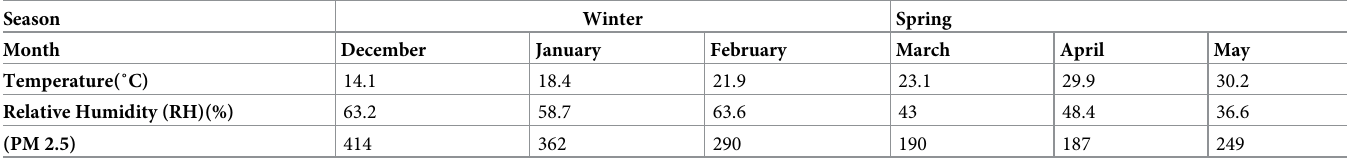
Table 4. Description of the meteorological parameters of the sampling areas (Particulate Matter PM 2.5 Data source: Ambient Air quality monitoring system (DPCC) Ashok Vihar, Delhi). Season Winter Spring